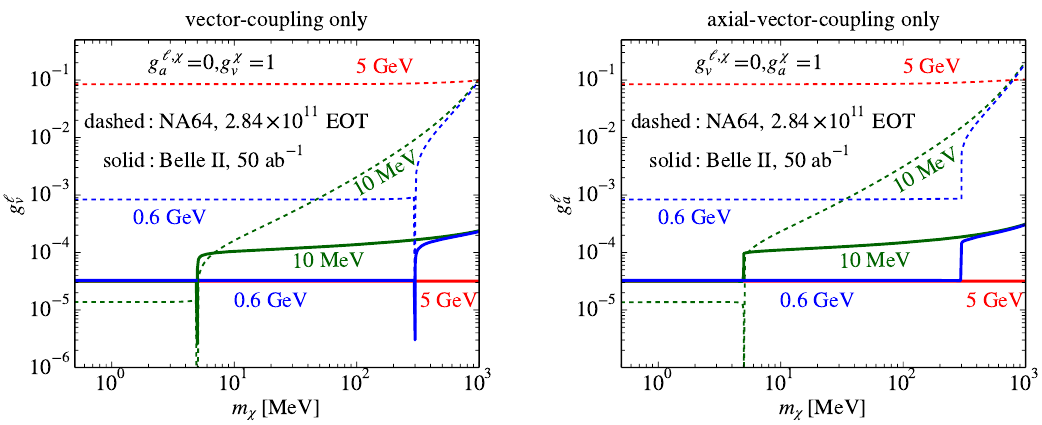
Figure 10 . NA64 90% C.L. upper bond on the EFT operators: Λ A (dot-dashed), Λ V (solid), Λ s (dotted), and Λ (dashed). The Belle II sensitivities are the same as figure 1. t